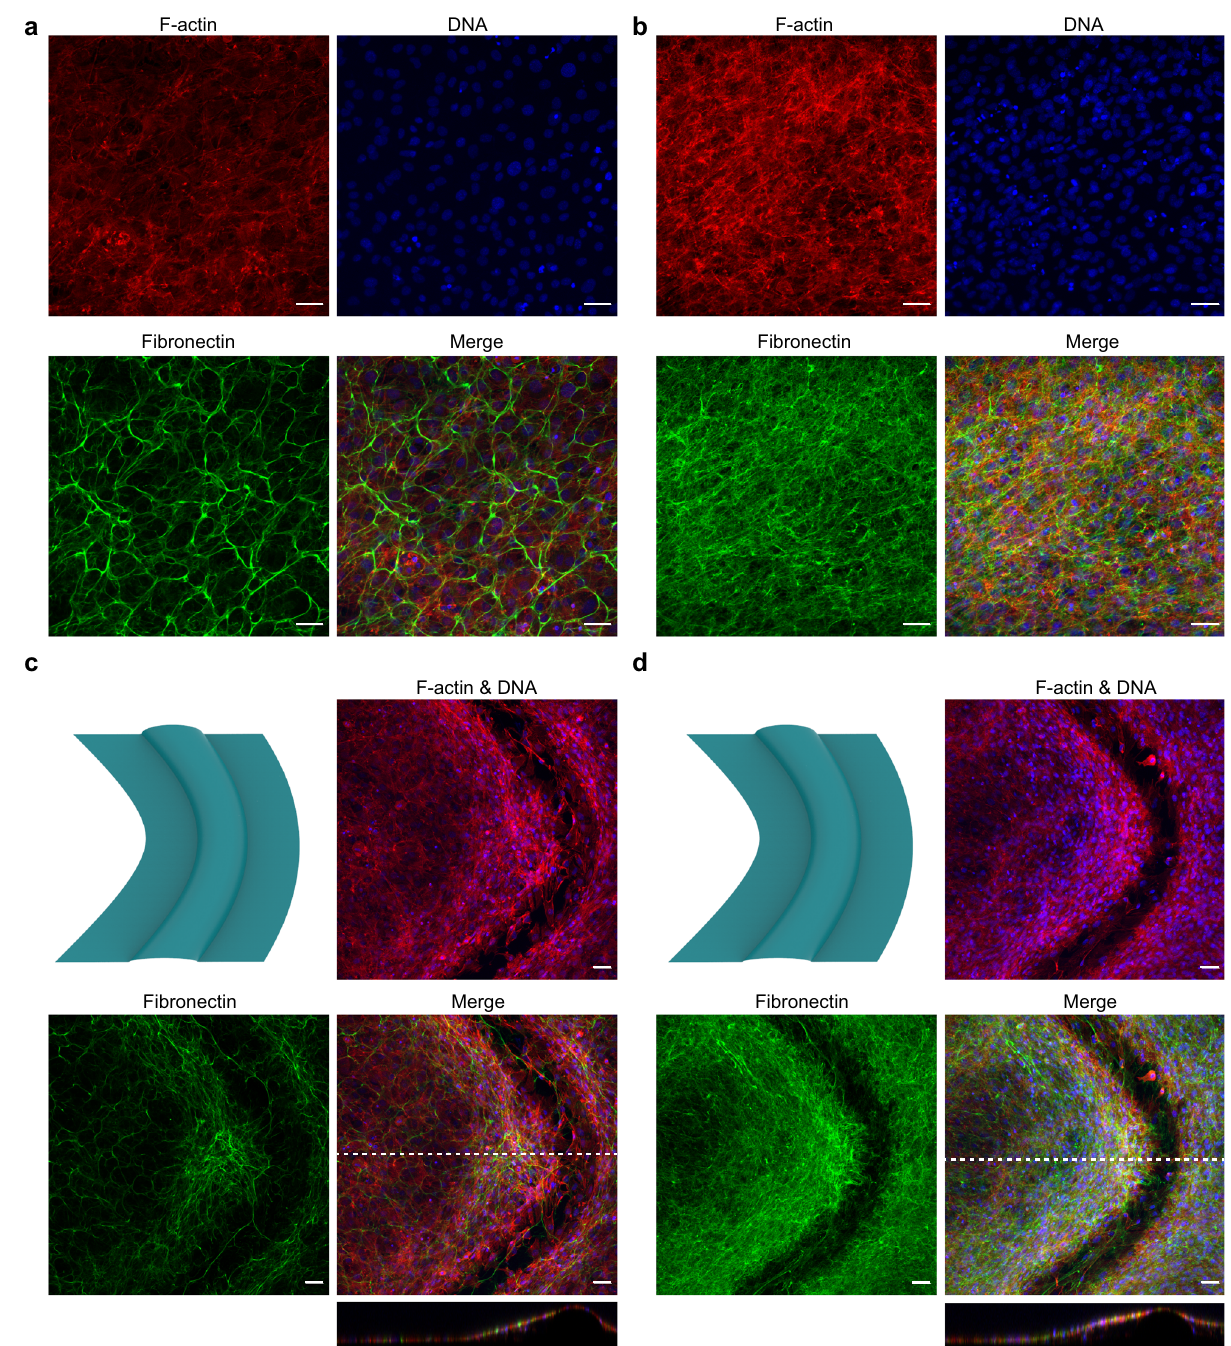
Fig. 8 | The effect of osteogenic supplement deprivation on early ECM devel- opment. a , b Representative fl uorescent staining of F-actin (red), DNA (blue), and fi bronectin (green) on a fl atregion after8 days, in mediumdeprived of osteogenic